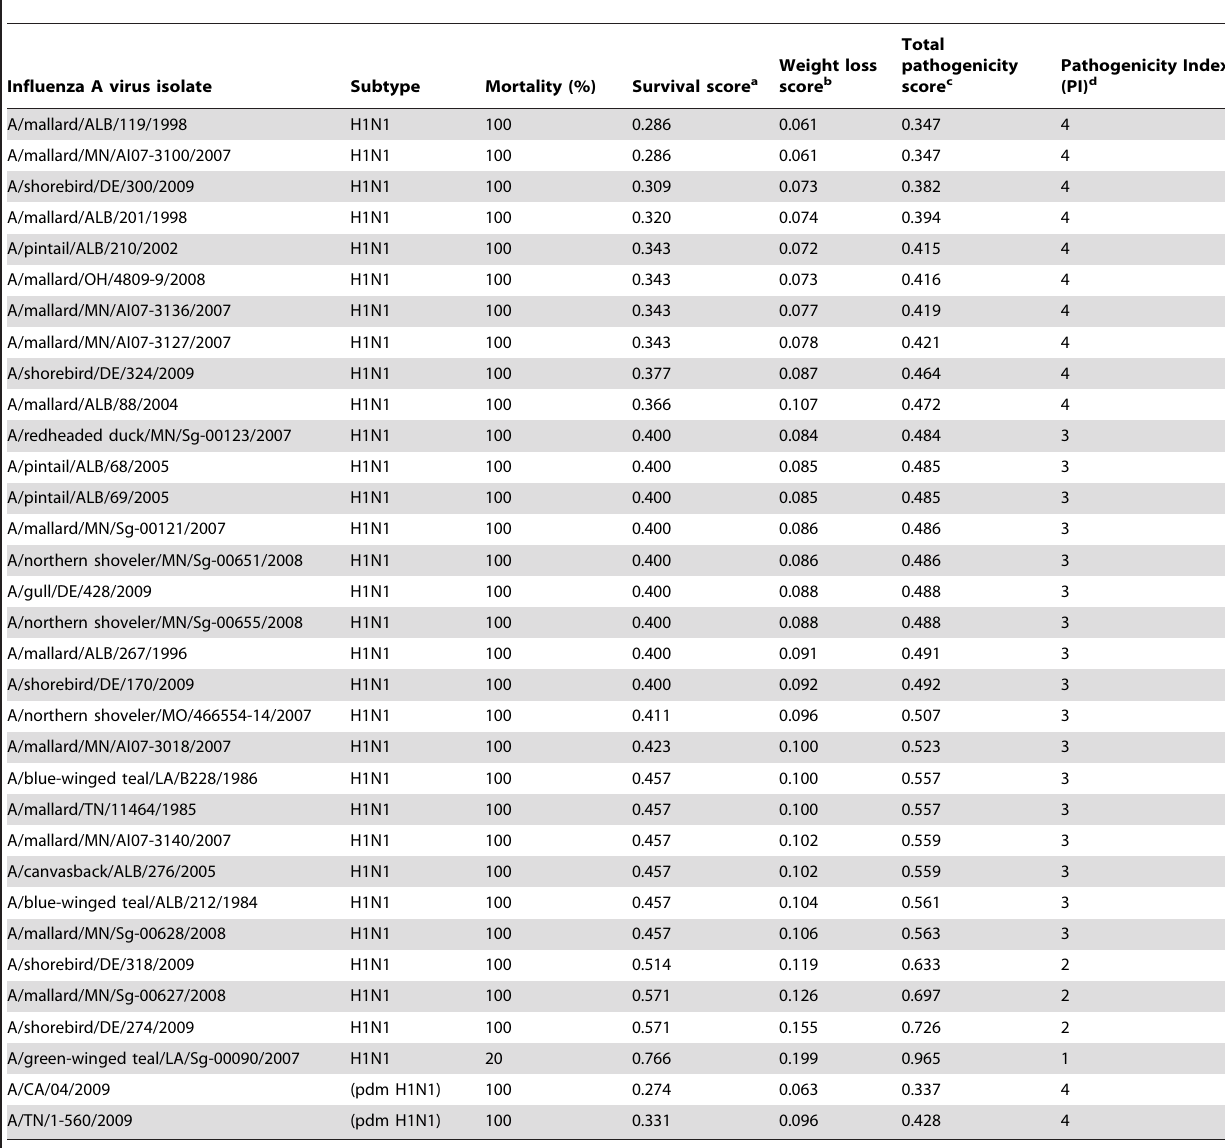
Table 1. Percent mortality and pathogenicity in DBA/2J mice infected with avian H1N1 virus isolates or pandemic H1N1 viruses (at 10 6 EID 50